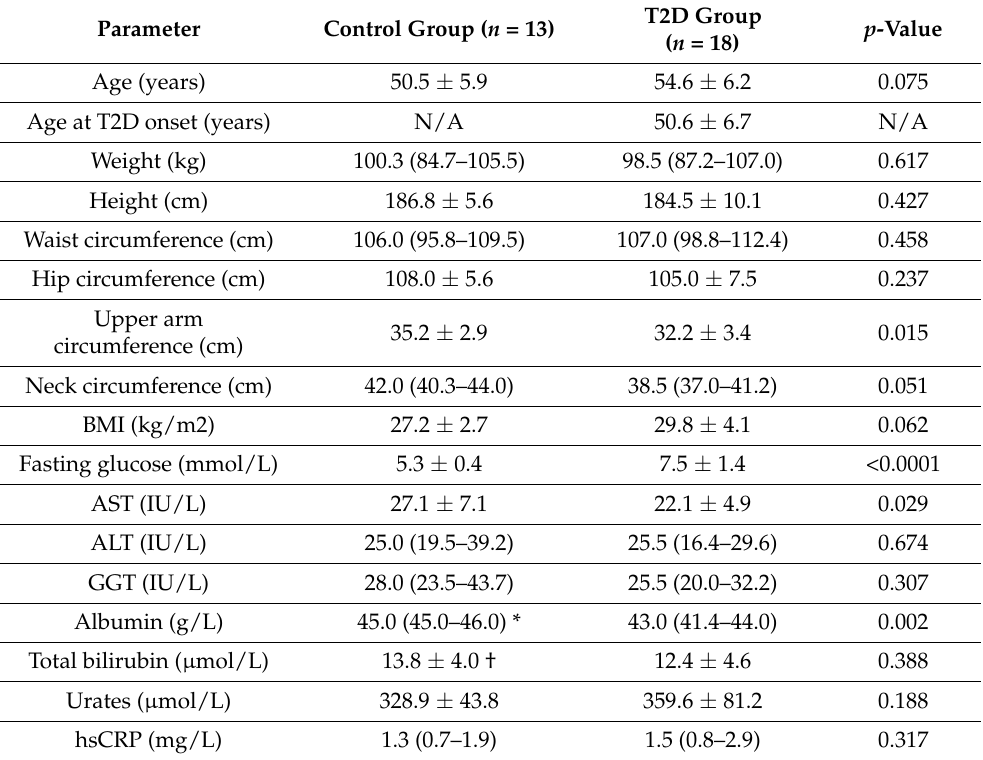
Table 1. Anthropometrical and biochemical data of participants with type 2 diabetes mellitus and control subjects at the baseline.